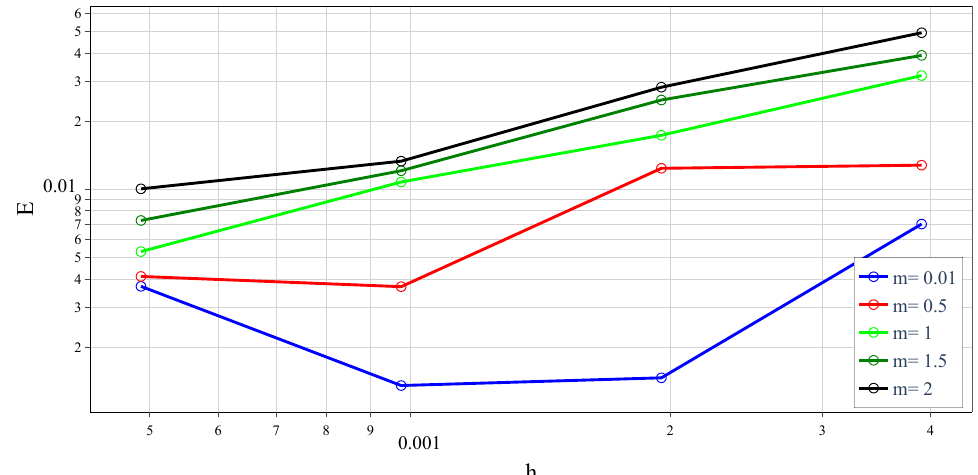
Figure 5. The relative error E = ( f num f ) / f versus the minimum mesh size h = L /2 J max with − J max = 8,9,10, and 11 for the fixed solid volume fraction ϕ s = 0.3 and different values of m = δ / h , which is the ratio of the Brinkman layer thickness δ to mesh size h